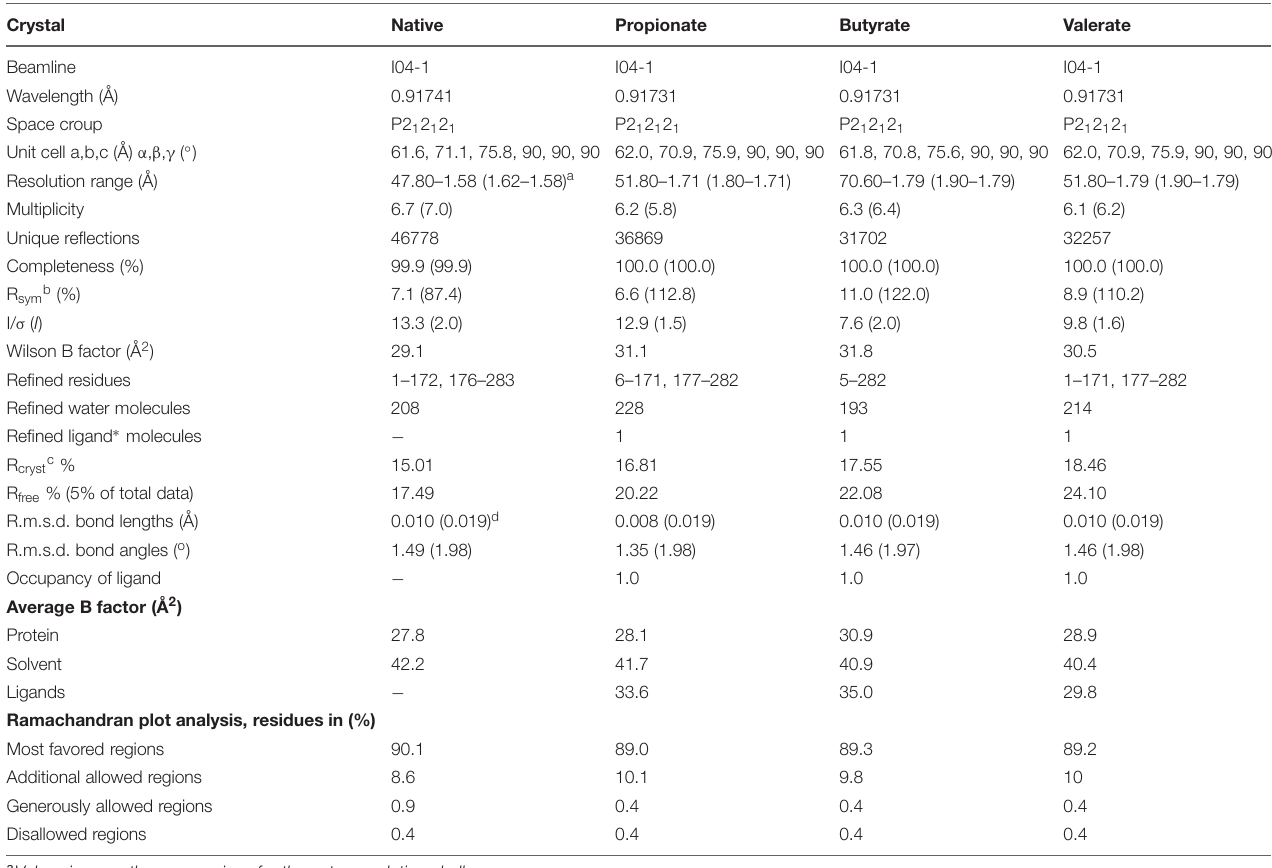
TABLE 1 | Summary of the data processing and refinement